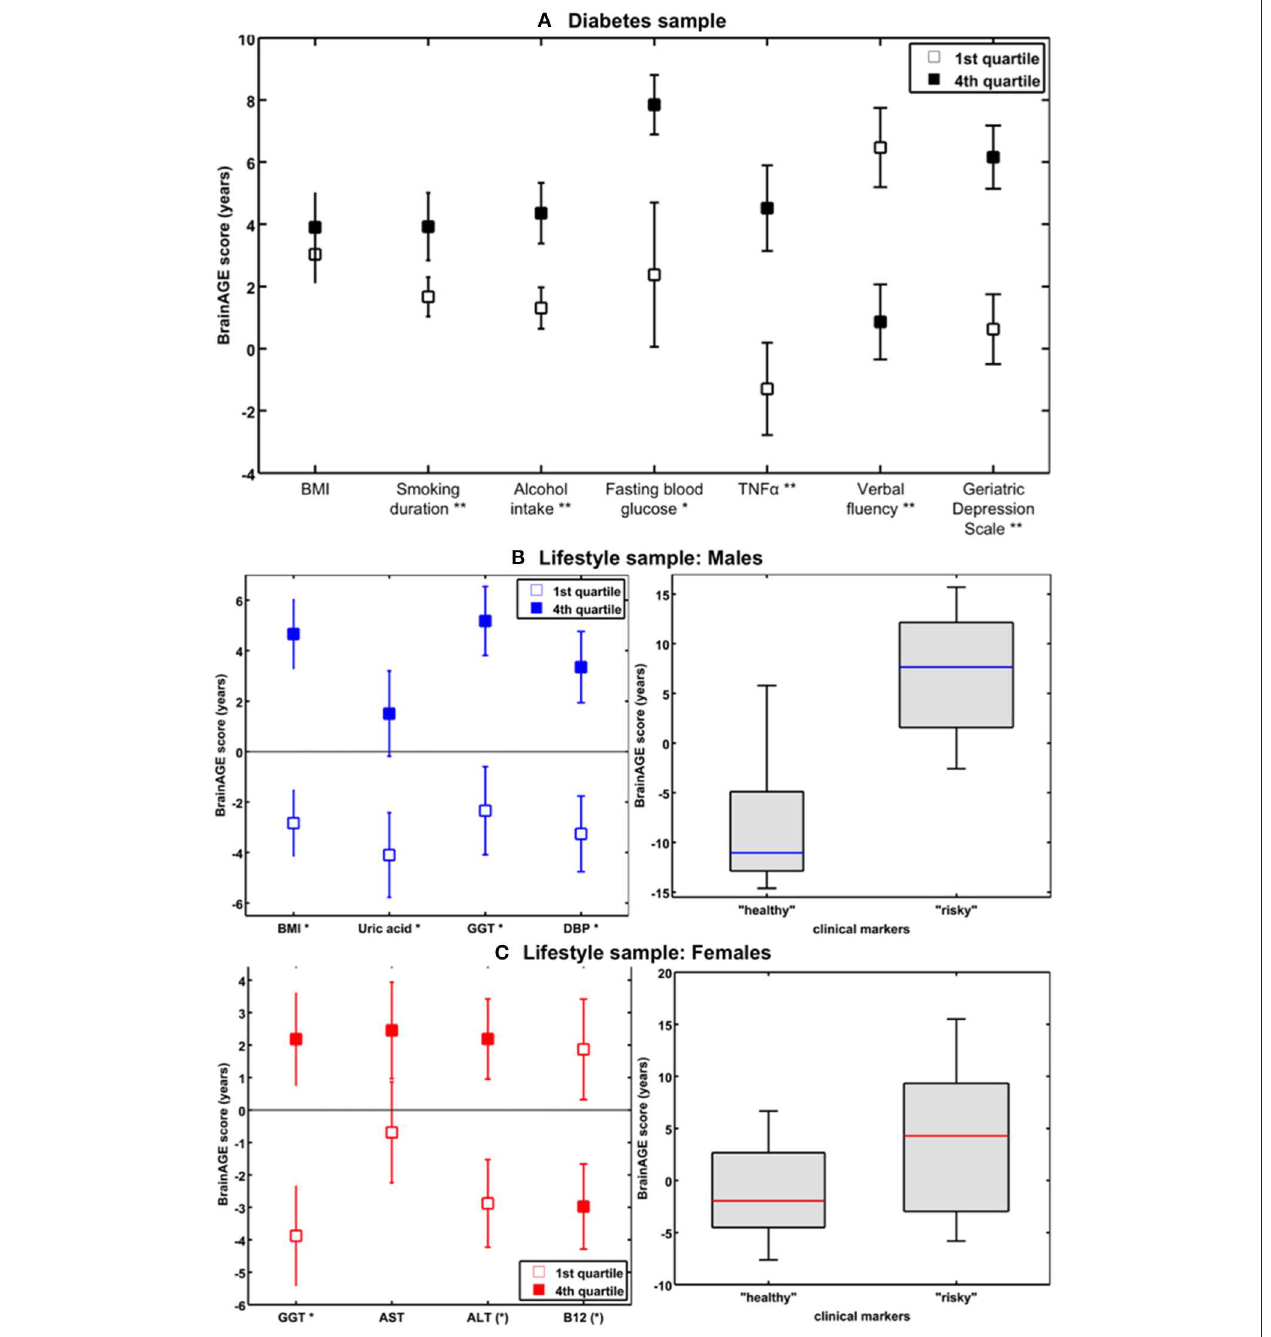
FIGURE 9 | The effects of low vs. high levels in distinguished variables on BrainAGE . (A) Mean BrainAGE scores in participants with values in the 1st (plain squares) and 4th (filled squares) quartiles of distinguished variables from the diabetes study. [Figure and legend reproduced from Franke et al. (41), permitted under the Creative Commons Attribution License.] (B) Mean BrainAGE scores of cognitively healthy CTR men in the 1st vs. 4th quartiles of the most significant physiological and clinical chemistry parameters (left panel). BrainAGE scores of cognitively healthy CTR men with “healthy” markers (i.e., values below the medians of BMI, DBP, GGT, and uric acid; n = 9) vs. “risky” markers (i.e., values above the medians of BMI, DBP, GGT, and uric acid; n = 14; p < 0.05; right panel). [Figures and legend modified from Franke et al. (42), permitted under the Creative Commons Attribution License.] (C) Mean BrainAGE scores of cognitively healthy CTR women in the 1st vs. 4th quartiles of the most significant physiological and clinical chemistry parameters (left panel). BrainAGE scores of cognitively healthy CTR women with “healthy” markers (i.e., values below the medians of GGT, ALT, AST, and values above the median of vitamin B 12 ; n = 14) vs. “risky” clinical markers (i.e., values above the medians of GGT, ALT, AST, and values below the median of vitamin B 12 ; n = 13; p < 0.05; right panel). [Figures and legend modified from Franke et al. (42), permitted under the Creative Commons Attribution License]. * p < 0.05; ** p < 0.01.